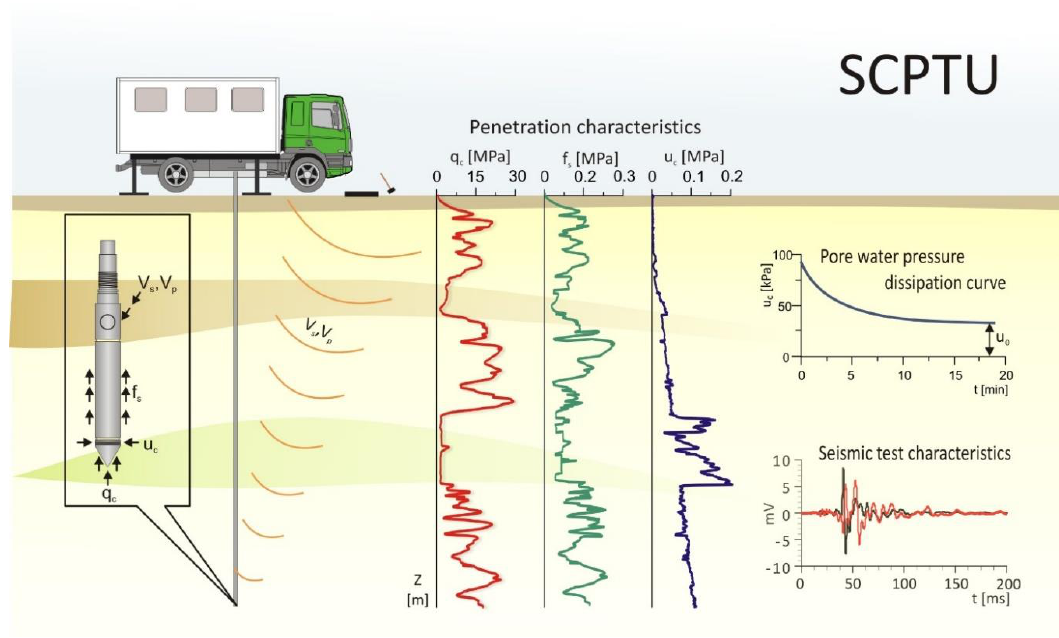
Figure 5. Principles of seismic piezocone testing.